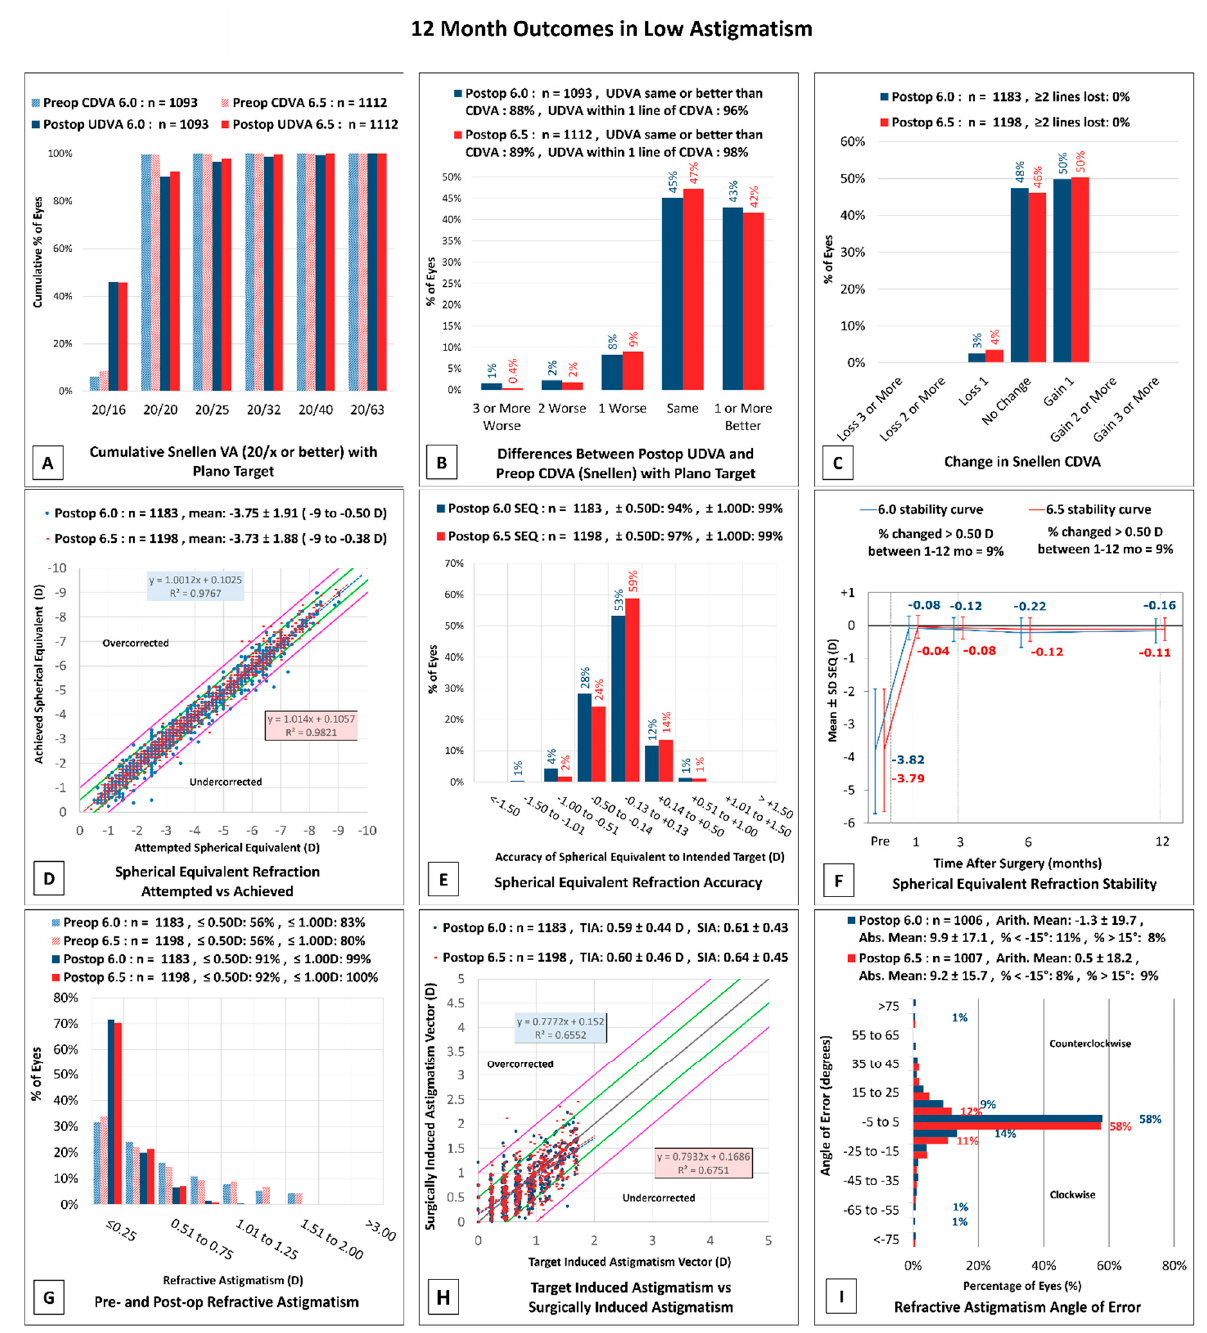
Figure A4. Standard reporting of visual and refractive outcomes for eyes at twelve months postoperatively between 6.0 and 6.5 mm in Low Astigmatism. ( A ) Cumulative preoperative CDVA and postoperative UDVA; ( B ) difference between preoperative CDVA and postoperative UDVA; ( C ) change in Snellen CDVA; ( D ) attempted vs. achieved MRSE; ( E ) accuracy of MRSE; ( F ) MRSE stability at one, three, six, and 12 months; ( G ) comparison of preoperative and postoperative manifest cylinder; ( H ) target-induced vs. surgically-induced astigmatism; ( I ) angle of error.